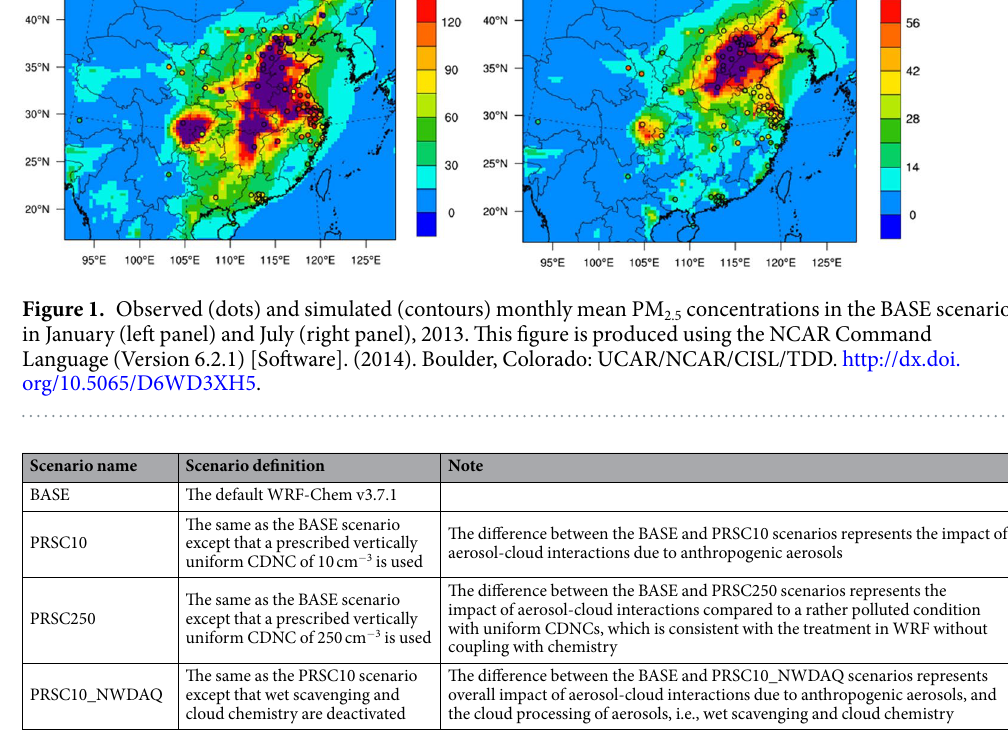
Table 2. Scenarios for evaluation of the impact of aerosol-cloud